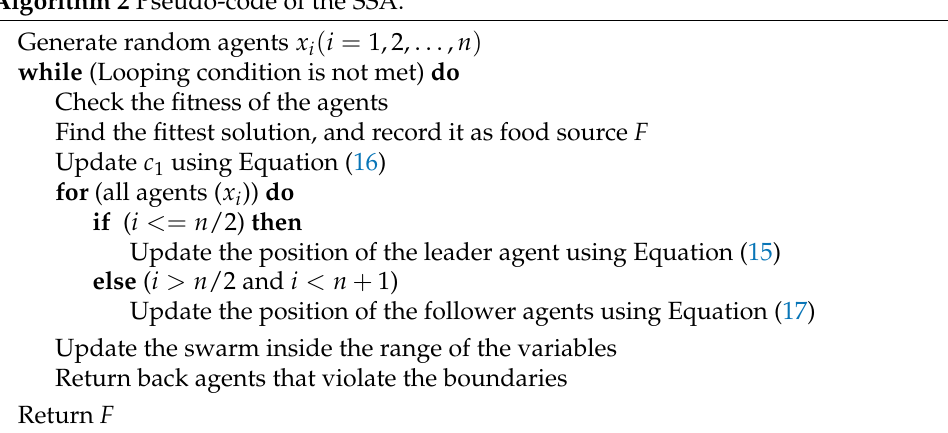
Algorithm 2 Pseudo-code of the